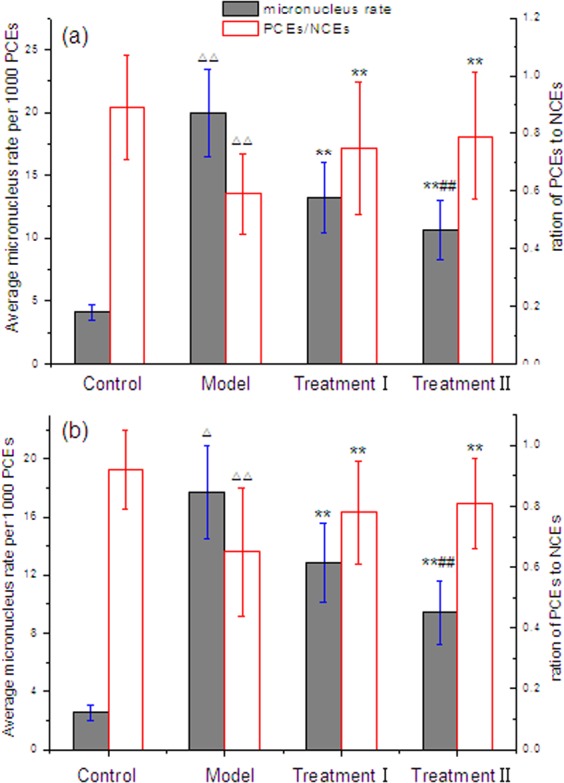
Effect of cytoprotector candidates on incidence of micronucleated polychromatic erythrocytes in bone marrow cells of mice treated with methotrexate.(A) male mice; (B) female mice; (1) Control Group = saline; Model Group = methotrexate + normal saline; Treatment Group I = methotrexate + combination of polyphenols and eleutherosides; Treatment Group II = methotrexate + combination of proanthocyanidins and eleutherosides. (2) ΔP < 0.05, ΔΔP < 0.01 vs control. (3) ∗P < 0.05, ∗∗P < 0.01 vs Model Group. (4) #P < 0.05, ##P < 0.01 vs Treatment I.